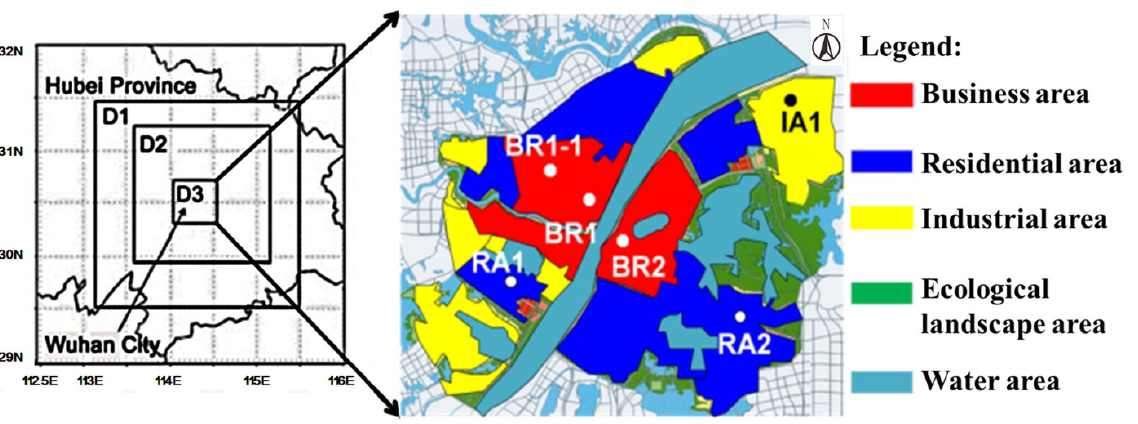
Figure 3. Computational domains and locations.